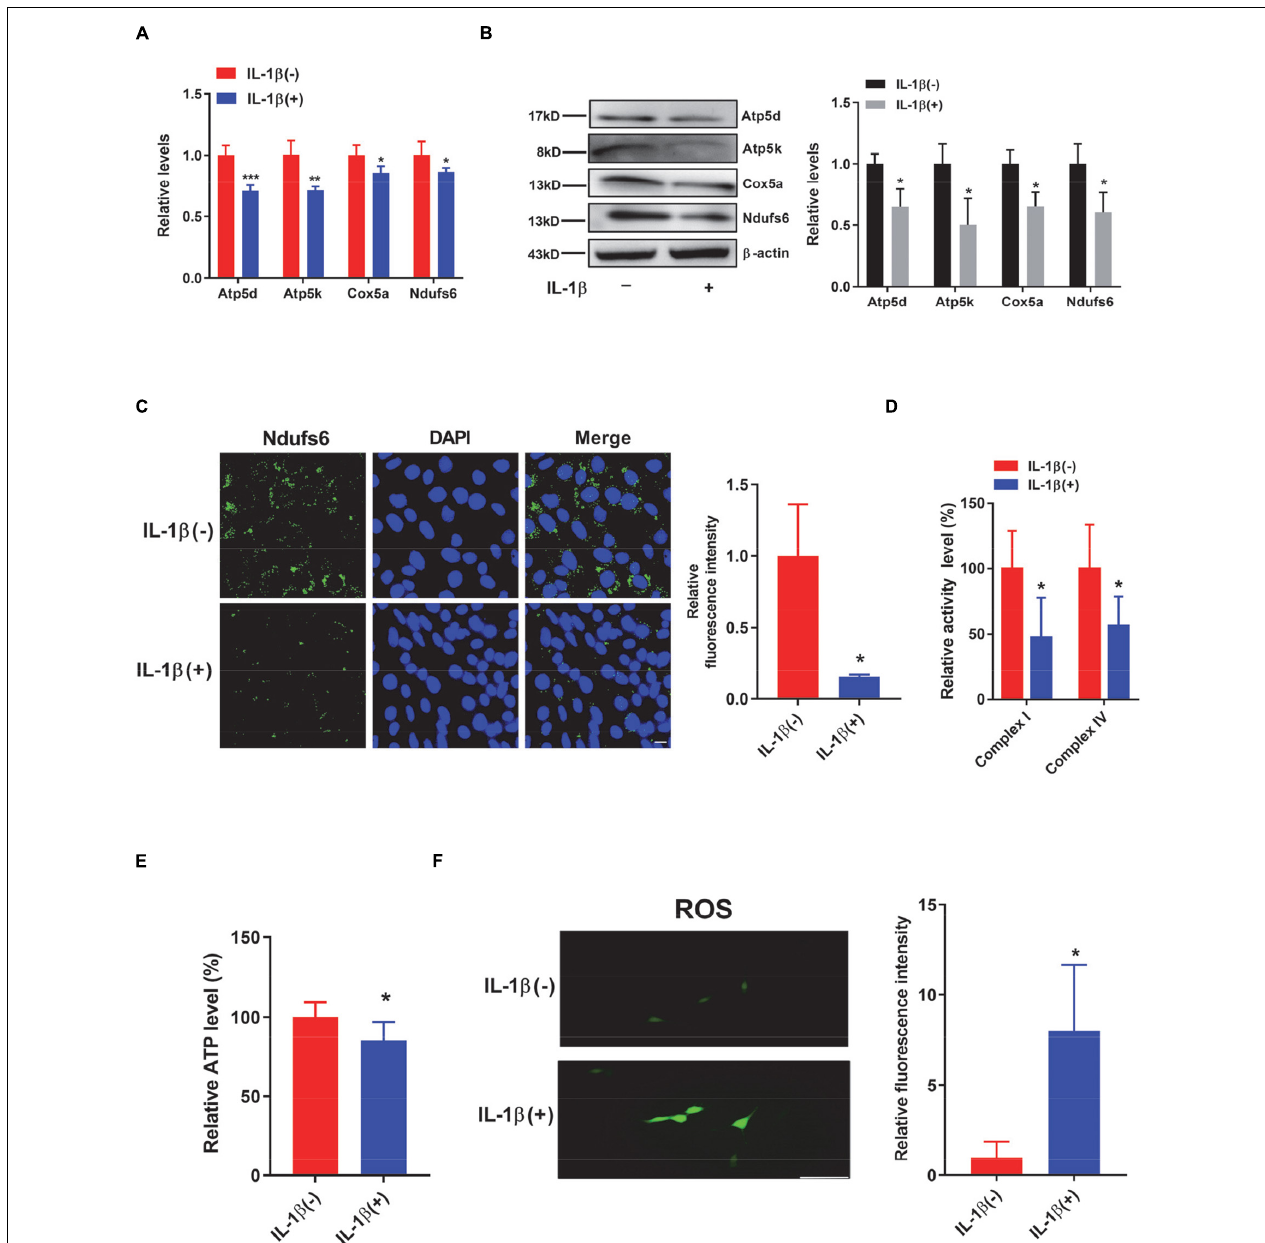
FIGURE 5 | HT22 cells treated with interleukin-1 β (IL-1 β ) show reduced respiratory complex levels and decreased mitochondrial respiratory function. (A–F) HT22 cells were treated with IL-1 β for 48 h. Levels of selected respiratory chain components were assessed by Quantitative PCR (qPCR) ( n = 8 per group) (A) and by immunoblotting and densiometric analysis (B) ( n = 4 per group). (C) Representative immunofluorescence images of Ndufs6 (green) and DAPI (blue) in control and IL-1 β -treated HT22 cells. Scale bar: 20 µ m. Relative immunofluorescence intensity was plotted in IL-1 β -treated HT22 cells over control HT22 cells ( n = 3 per group). (D) The enzymatic activities of complex I and complex IV were determined by an ELISA-based approach ( n = 6 per group). (E) Adenosine triphosphate (ATP) levels were determined in HT22 cells by an ELISA-based analysis. Relative ATP levels were plotted in IL-1 β -treated HT22 cells over control HT22 cells ( n = 8 per group). (F) Representative images of reactive oxygen species (ROS) (green) in HT22 cells treated with or without IL-1 β using a DCFHDA fluorescence probe. Scale bar: 50 µ m. Relative immunofluorescence intensity was plotted in IL-1 β -treated HT22 cells over control HT22 cells ( n = 3 per group). * P < 0.05; ** P < 0.01; *** P < 0.001 by independent samples Student’s t -test; error bars denote the